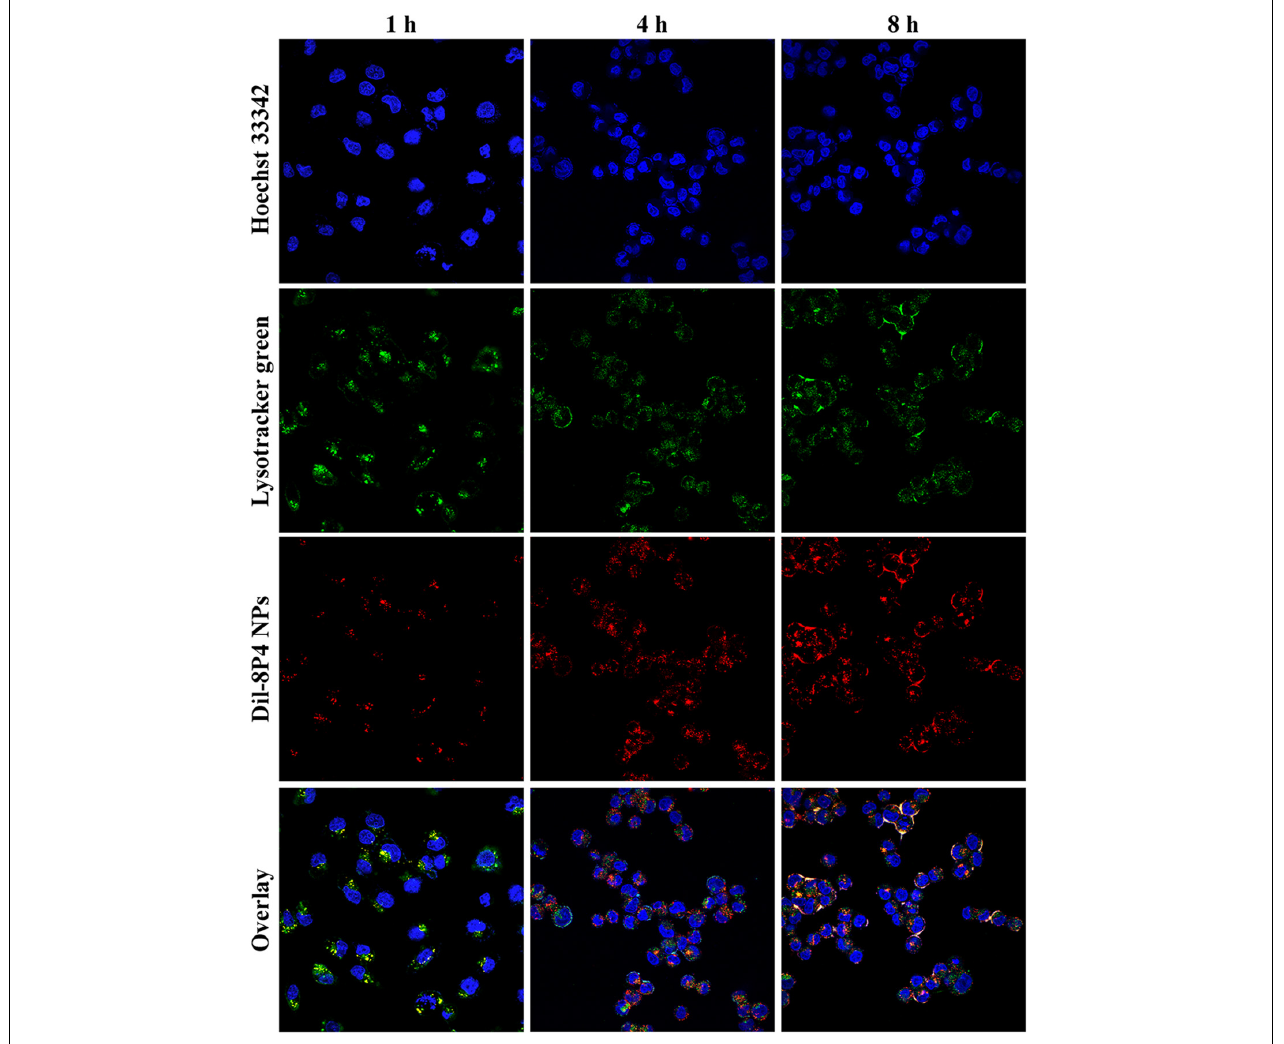
FIGURE 5 | Confocal laser scanning microscope images of A549 cells incubated with 5 mg/ml Dil-8P4 NPs. The nuclei and endosome were stained with Hoechst 33342 (blue) and LysoTracker green (green), respectively (60 ×